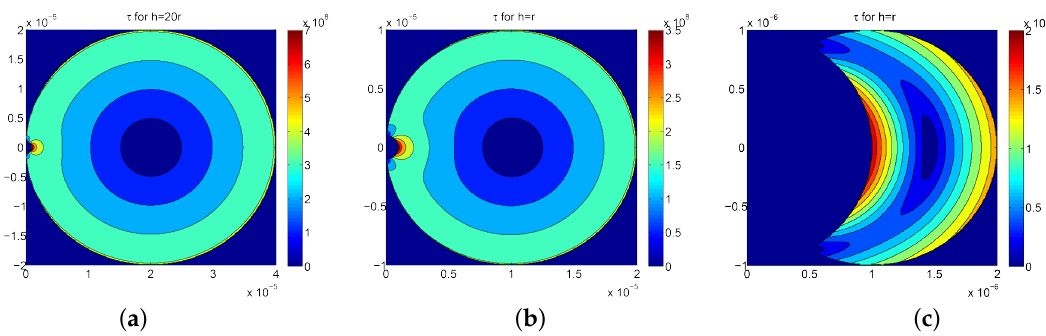
Figure 9. Shear stress module (Pa) in the cross section calculated through a 400 × 400 nodes grid with the analytical approach where: h